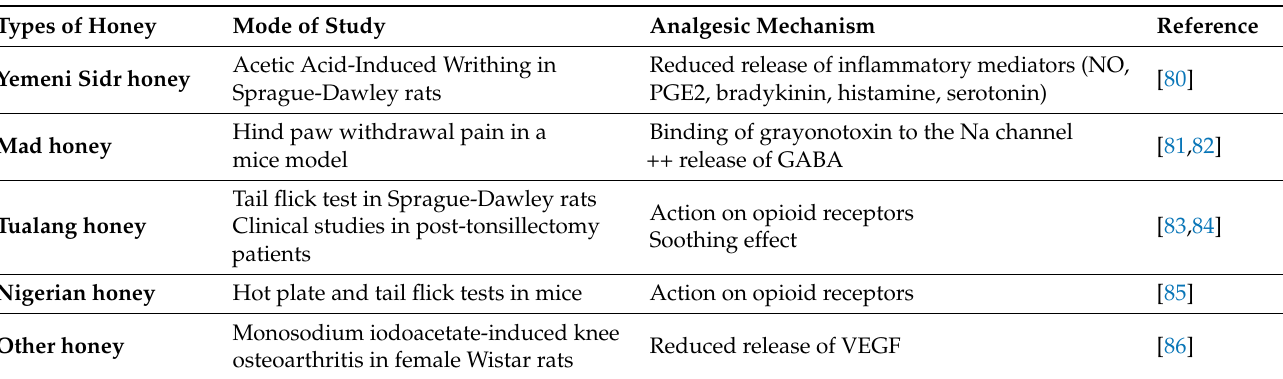
Table 5. Analgesic mechanism of various types of